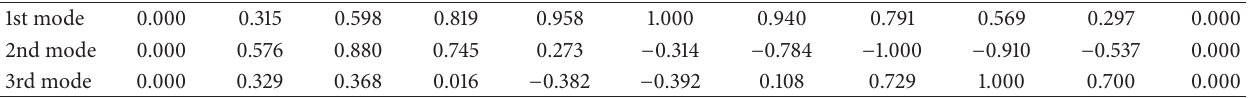
Table 11: Optimal mode shapes (Case2A).